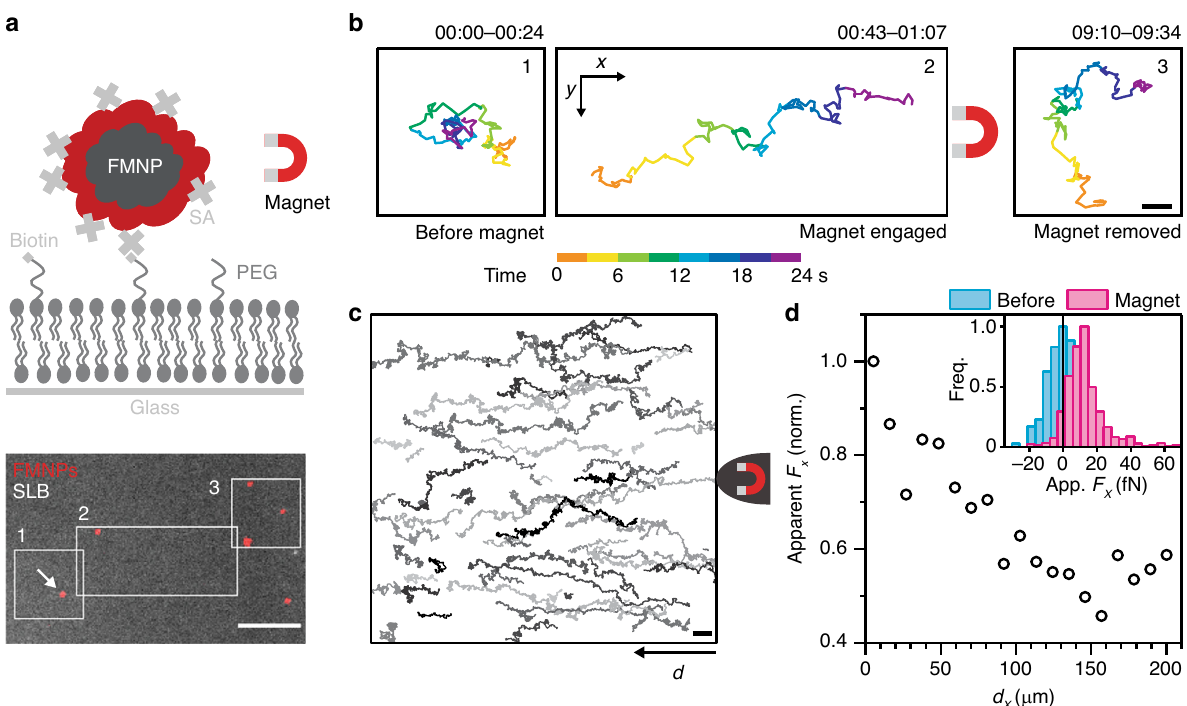
Fig. 1 Manipulation of lipids by FMNPs on an SLB and force calibration. a Experimental setup for the directed manipulation of a streptavidin (SA)- functionalized FMNP bound to biotinylated lipid (DSPE-PEG(2k)-biotin) in a SLB. Graphic is not to scale. Below: Overlay of the fi rst frame of a fl uorescence time-lapse video of FMNPs (red) bound to a SLB doped with carboxy fl uorescein-conjugated lipid (DOPE-CF, gray). Scale bar is 10 μ m. b Trajectory of the FMNP marked with an arrow in a before (1), during magnetic manipulation (2) and afterwards (3) colored by time. Scale bar is 2 μ m. c Trajectories of FMNPs tracked on a SLB with the very tip of the magnetic needle placed to the right. A subset of all tracks is shown in random gray levels for clarity. d Distance dependency of the apparent force. Forces were calculated for sliding windows of each trajectory in the data set in c and mapped to the average distance d x from the tip in direction of x . Inset: Histogram of apparent forces F x per trajectory exerted on FMNPs in presence (magenta, 711 tracks) and absence (blue, 178 tracks) of the magnetic needle. Source data are provided as a Source Data fi